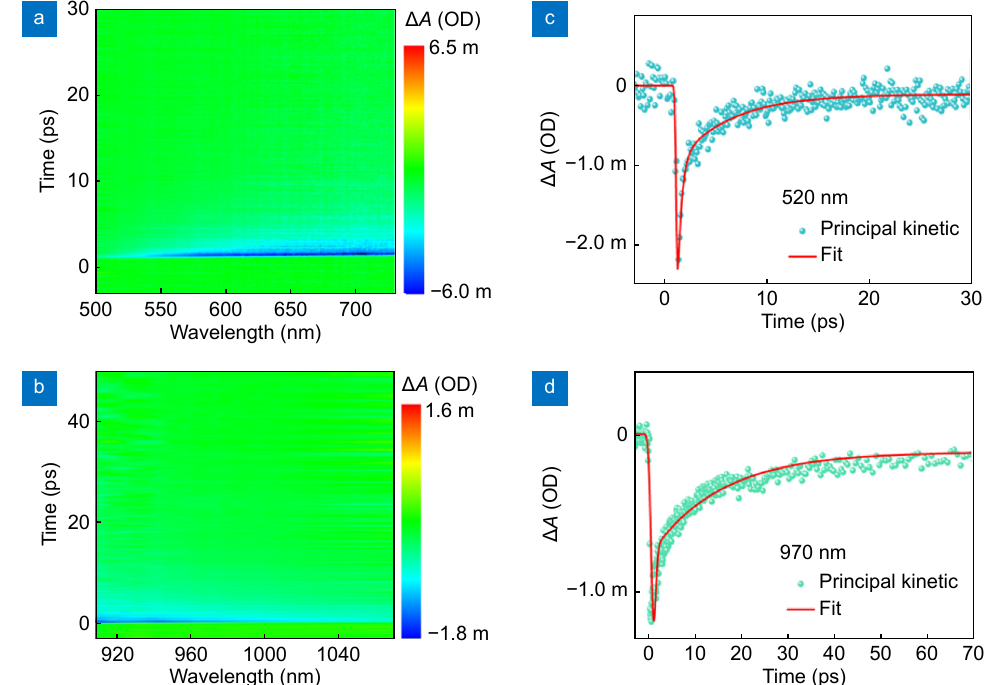
Fig. 2 | ( a , b ) 2D mapping of TA spectra from 500 nm to 730 nm, and from 910 nm to 1070 nm. Horizontal axis, vertical axis, and color scale rep- resent the probe wavelength, the pump-probe time delay, and the intensity of TA signal, respectively. The dynamic curves and fitted results of the BQDs at 520 nm ( c ) and 970 nm ( d